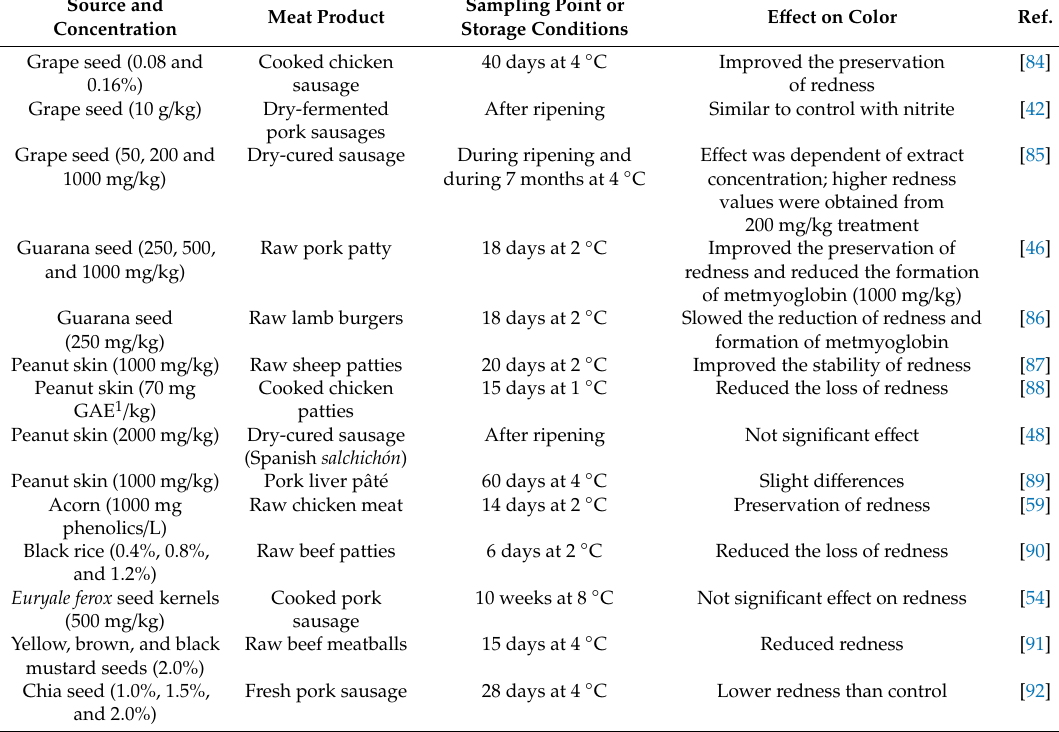
Table 3. Influence of seed extracts on the color of meat